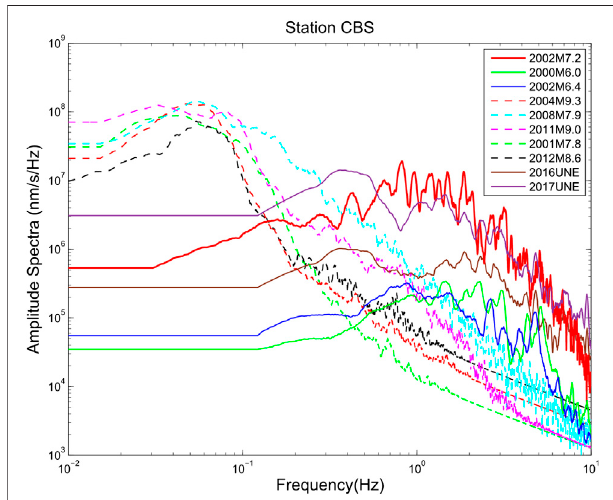
FIGURE 8 | Amplitude spectra for the Wangqing earthquake and other deep-focus earthquakes and shallow distant earthquakes. Dashed curves correspond to shallow distant earthquakes, and solid lines to deep-focus earthquakesandthelargestUNEsinNorthKorea.Thelinear-likespectra at high-frequency ranges ( > 1 Hz) for some events are due to small gap in the continuous waveform, resulting in some high-frequency artefact.